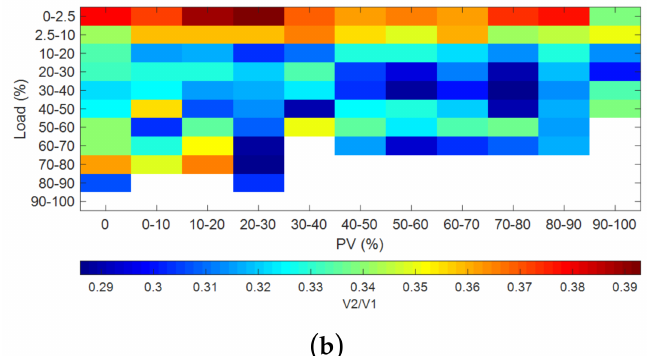
Figure 25. Behaviour of V 2 / V 1: ( a ) matrix of V 2 / V 1 values for PVS Of f scenarios and variations of V 2 / V 1 values for PVS On scenarios, and ( b ) average value per scenario.